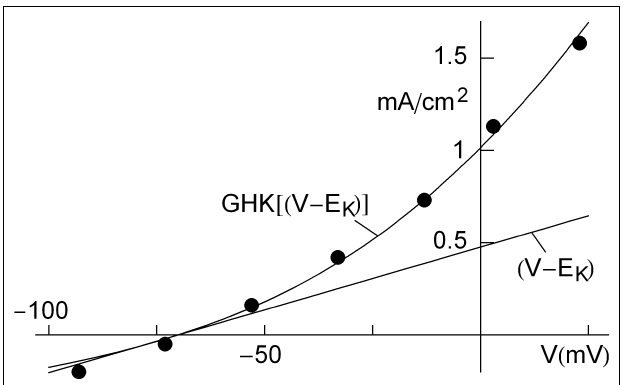
FIGURE 1 | Squid axon I is well described by GHK – Eq. 1 in the text – curve labeled GHK[(V − E